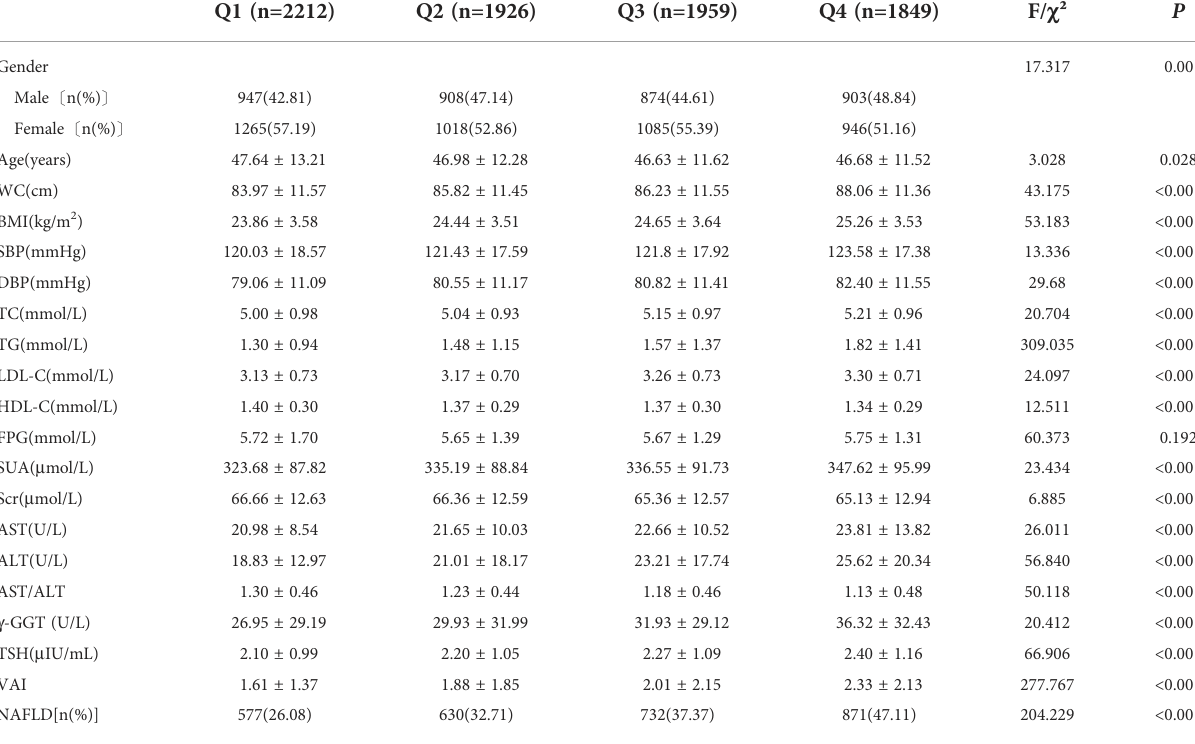
TABLE 1 Comparison of basic demographic characteristics of physical examinees with normal thyroid function in quartile groups of FT3/FT4 ratio. Q1